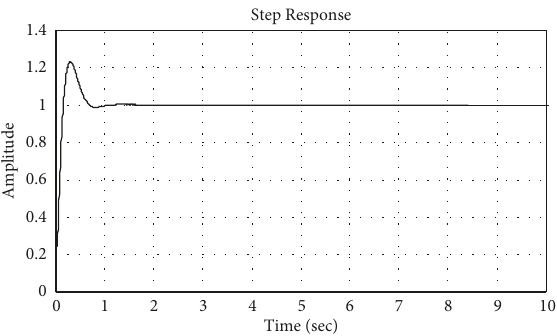
Figure 9: System PID control step response